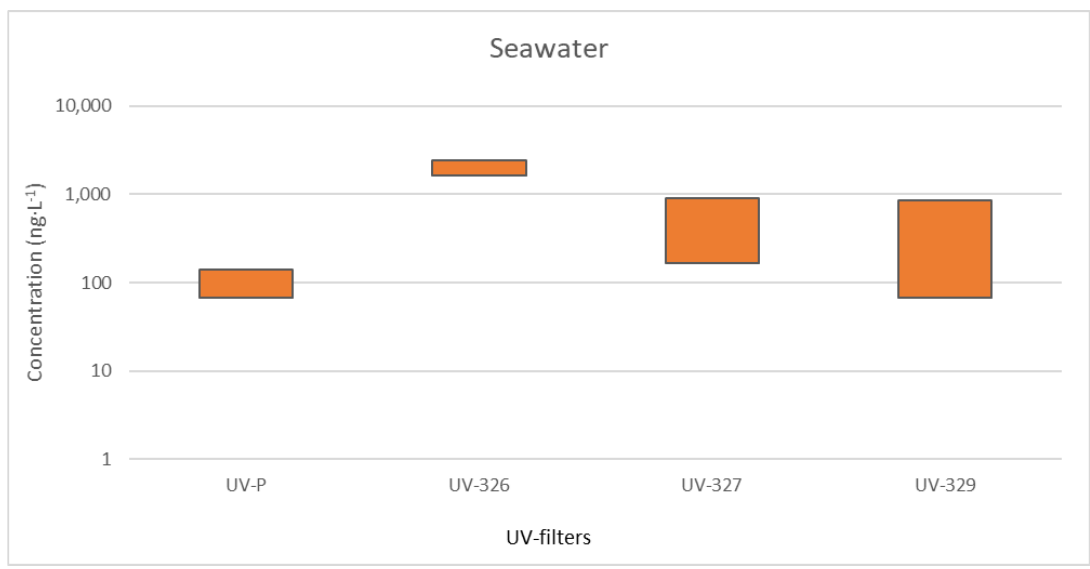
Figure 3. Range of concentrations (ng L −1 ) for detected benzotriazole UV stabilizers (BUVSs) in Figure3. Rangeofconcentrations(ngL − 1 seawater.